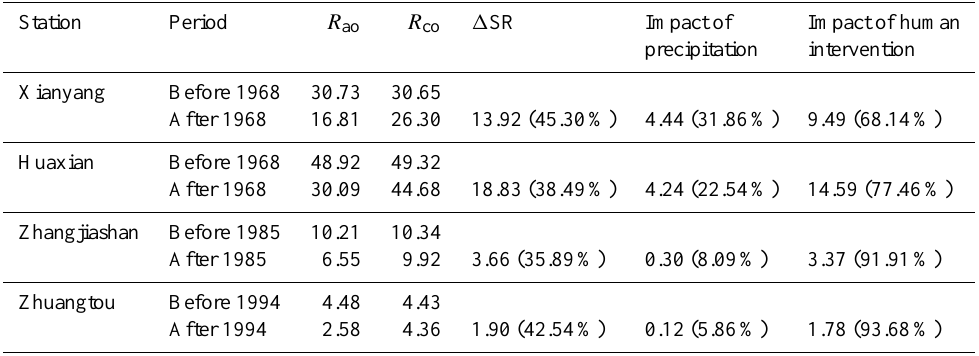
Table 6. The impact of precipitation and human intervention on stream flow decline after the change-point year at four stations in the Wei River basin (10 8 m 3 a − 1 ).